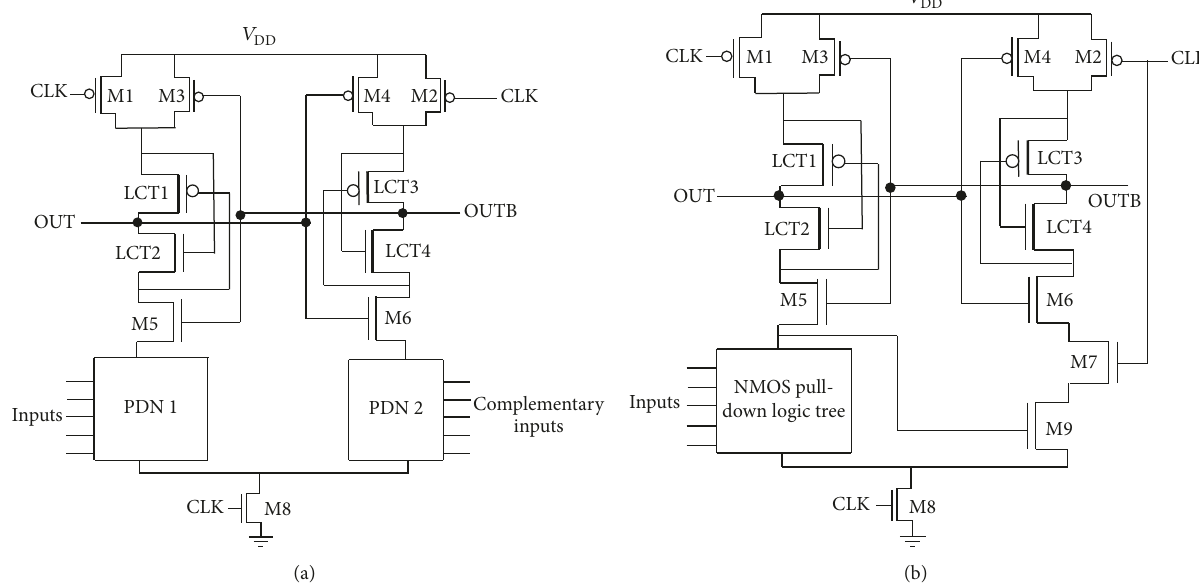
Figure 5: Proposed architecture-2 for (a) Dy-DCVSL-LCT circuits and (b) EDCVSL-LCT circuits.